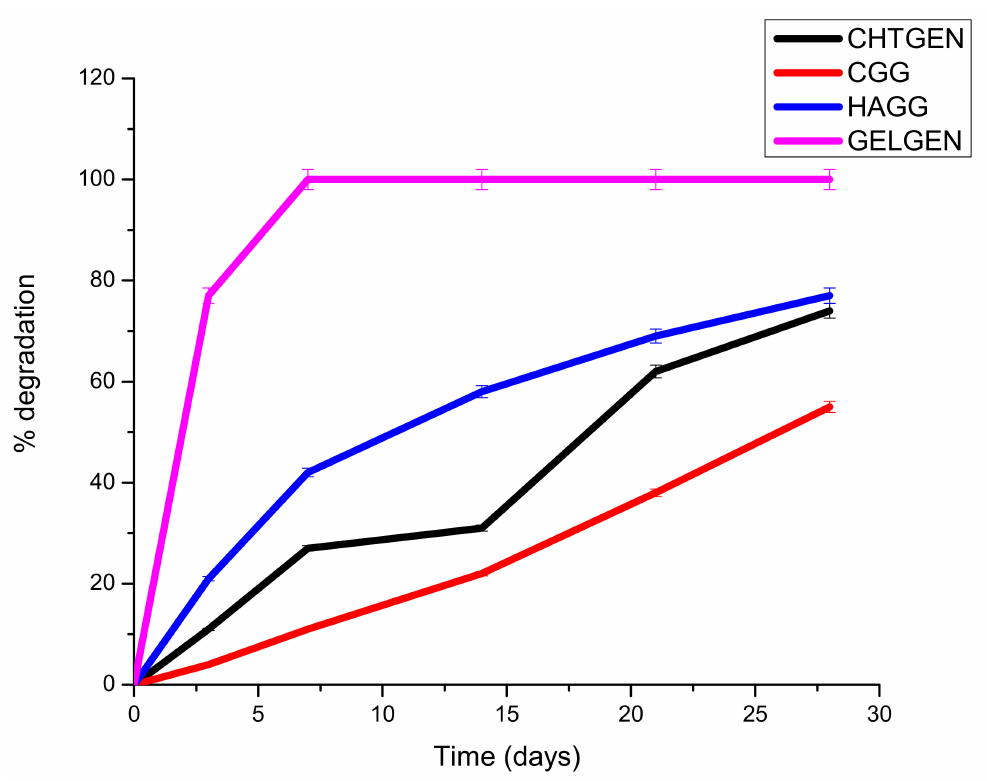
Figure 11. Degradation of genipin-crosslinked scaffolds undertaken over 30 days in the presence of PBS (n =